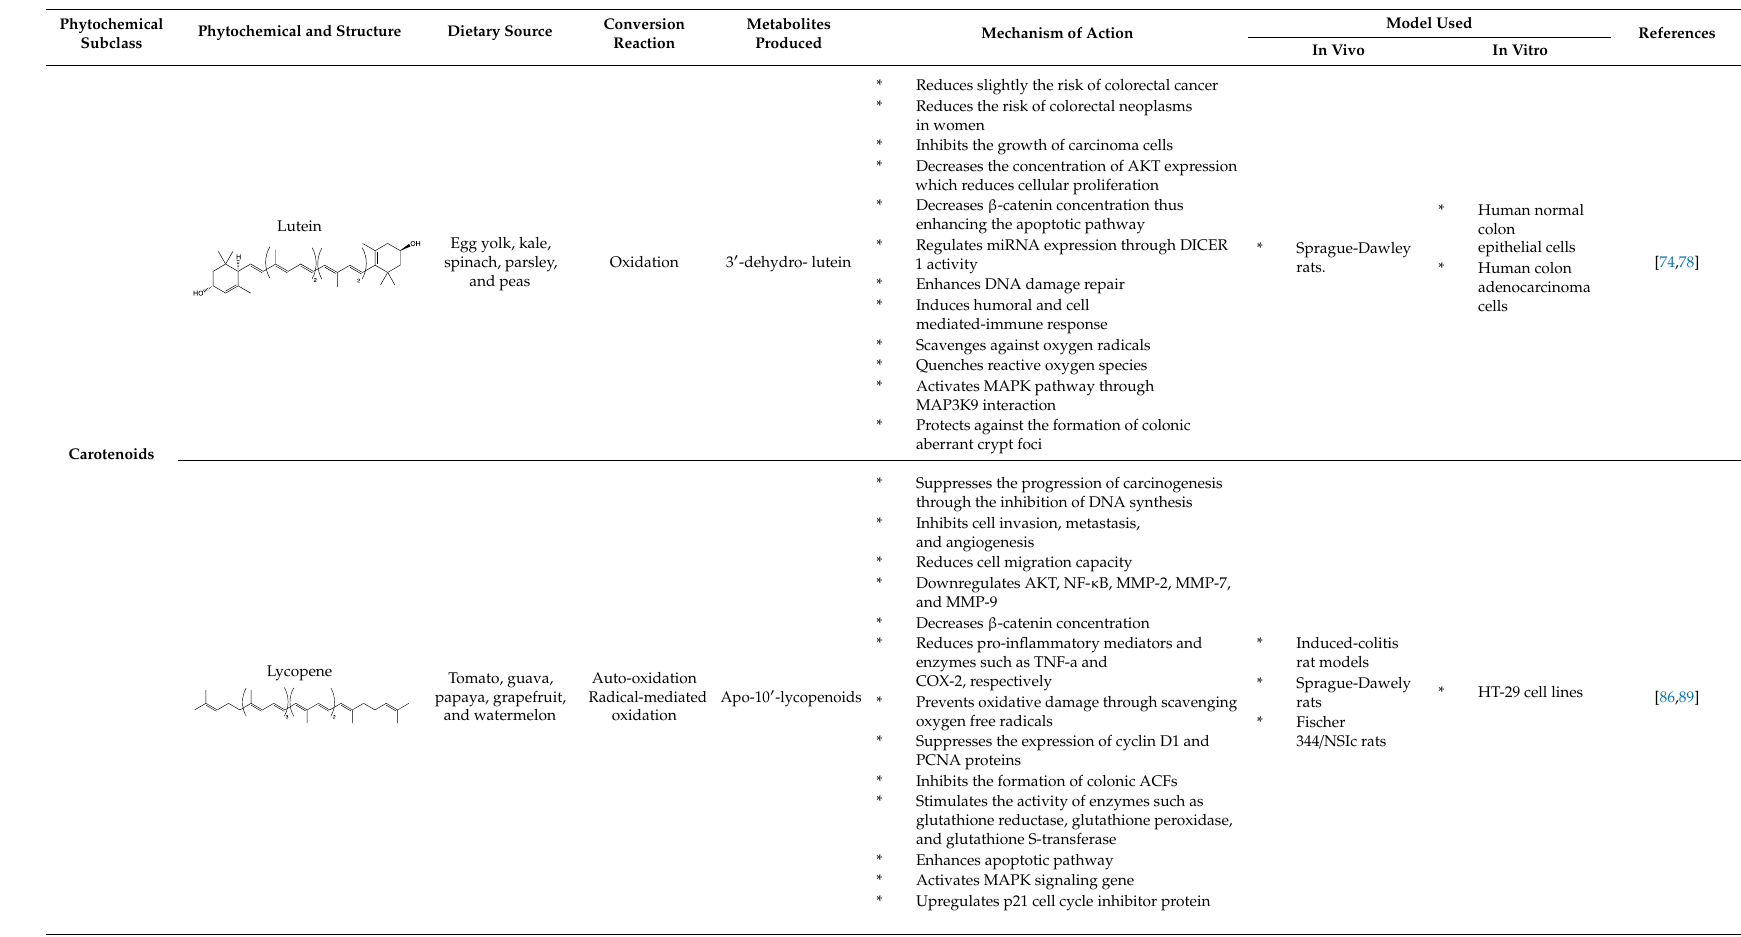
Table 1. Representive Phytochemicals and Their Underlying Anti-Cancerous E ff ects. Table 1.Representive Phytochemicals and Their Underlying Anti-Cancerous Effects